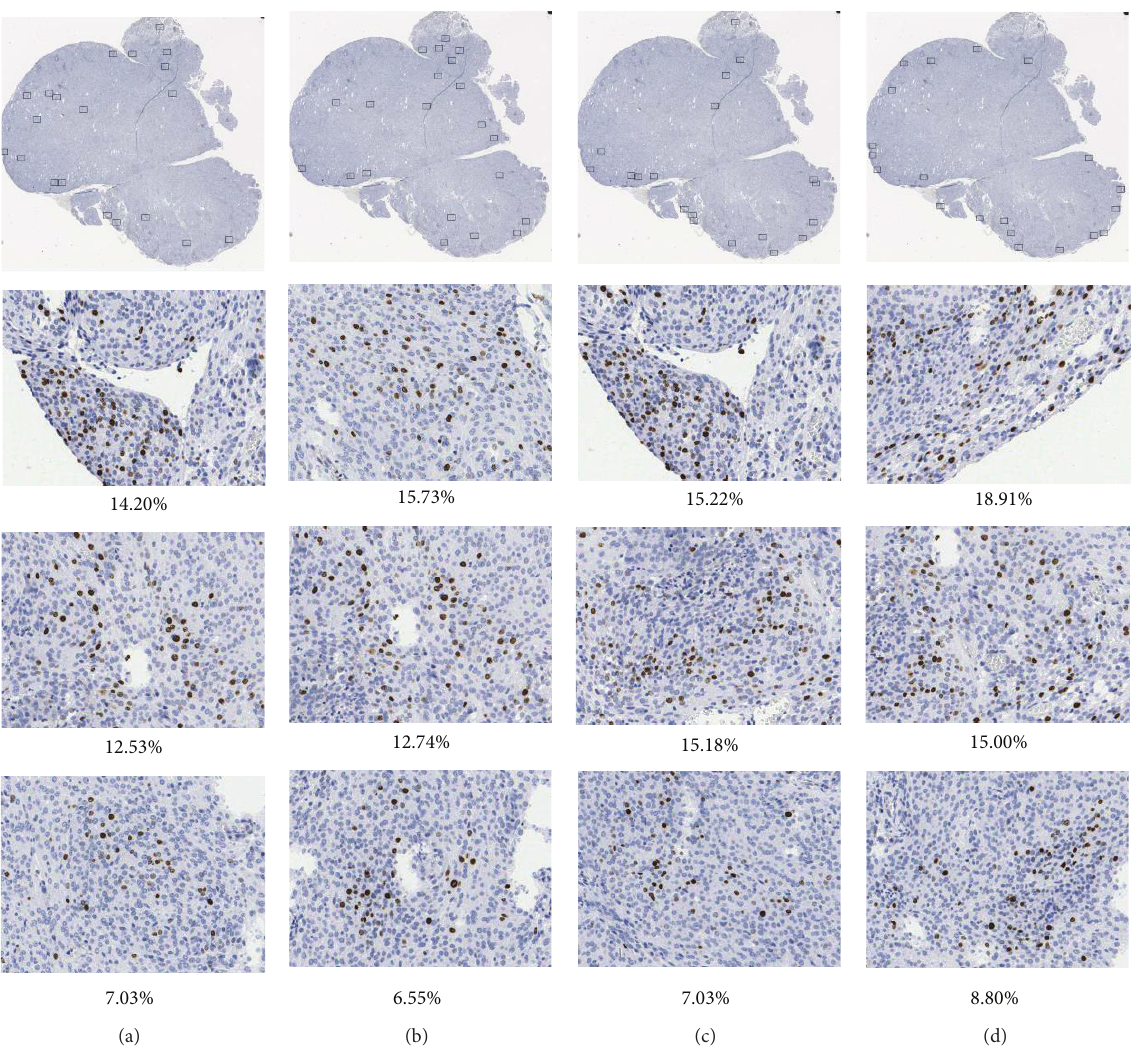
Figure 5: The results of hot spot and area of quantification selections by one pathologist ((a), (b), and (c)) and by proposed automated method (d) with examples of 3 areas of quantification chosen approximately in the same region (hot spot) for each selection. The Ki-67 index value calculated as percentage of immunopositive nuclei to the whole number of nuclei in presented area differs slightly.